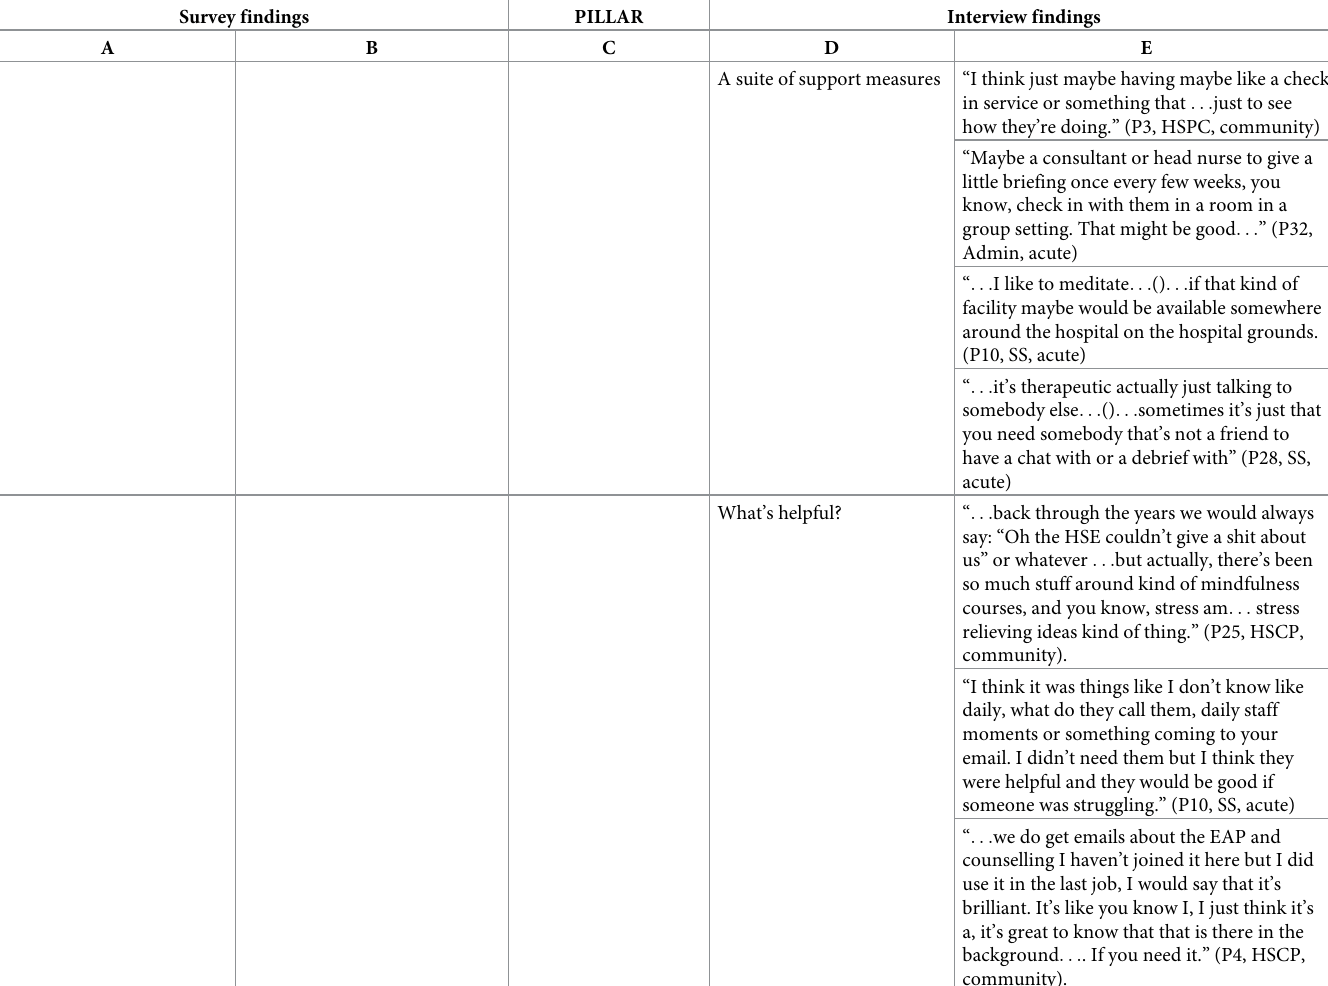
Pillar one—primacy of peer support. The findings from both the quantitative and quali- tative arm of the study converged in relation to participants’ use of collegial peer support mechanisms as a primary means of support while working through the pandemic. Over- whelmingly HCWs referenced their work colleagues, in particular peers or members of their team, as the principal point of support through the pandemic. This was echoed in the survey in that the most used supports were reported to include occupational health and other collegial supports, e.g. buddy system and end of shift huddles, in contrast to the more formal approaches of EAP and PFA. The majority of HCWs viewed peer support as an informal and reciprocal approach, in that support was both given and received by staff. There was an under- lying sense of relief that HCWs could share their experiences with their peers. There was some recognition that despite the value and importance of peer support, the impact of it on col- leagues well-being might be reducing. Particular difficulties were highlighted for individuals who were redeployed. While there was a recognition of good ‘team spirit’ for redeployed HCW, this went hand in hand with the perception that colleagues from their pre-pandemic work places were not always supportive. This was related to a concern that redeployed